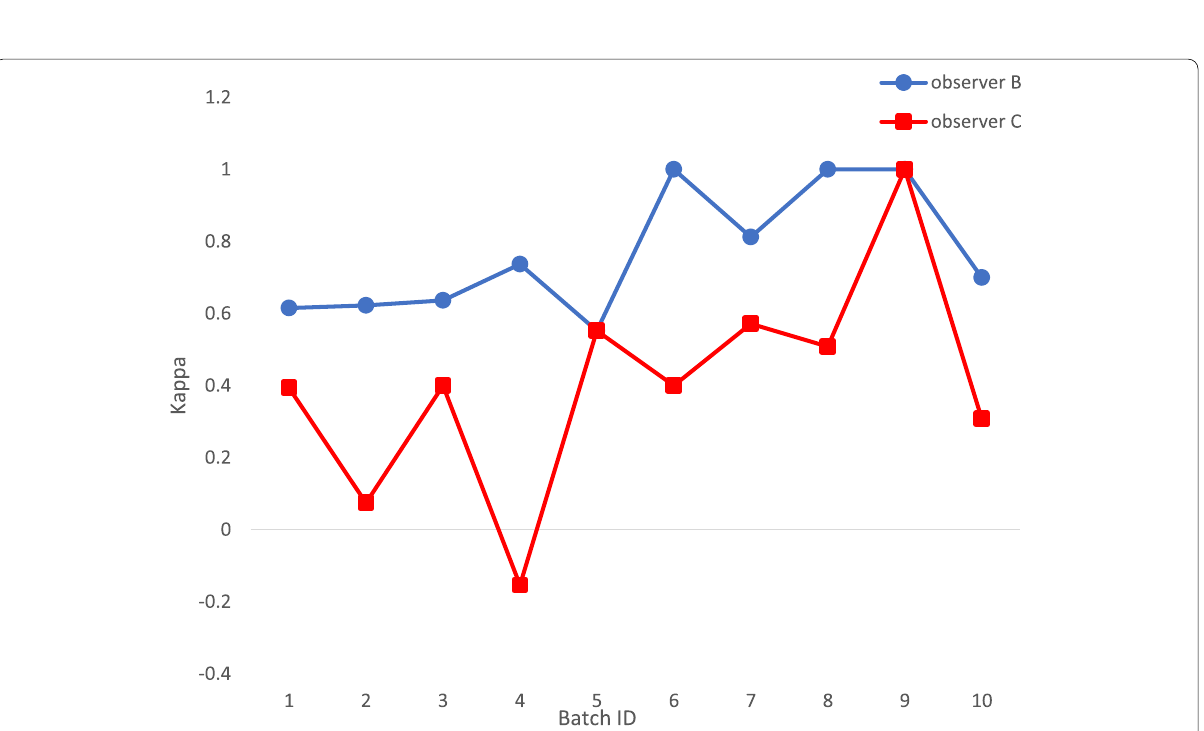
Fig. 2 Kappa values for the variation between the novice observers and the experienced observer on the oropharynx level after each cluster of